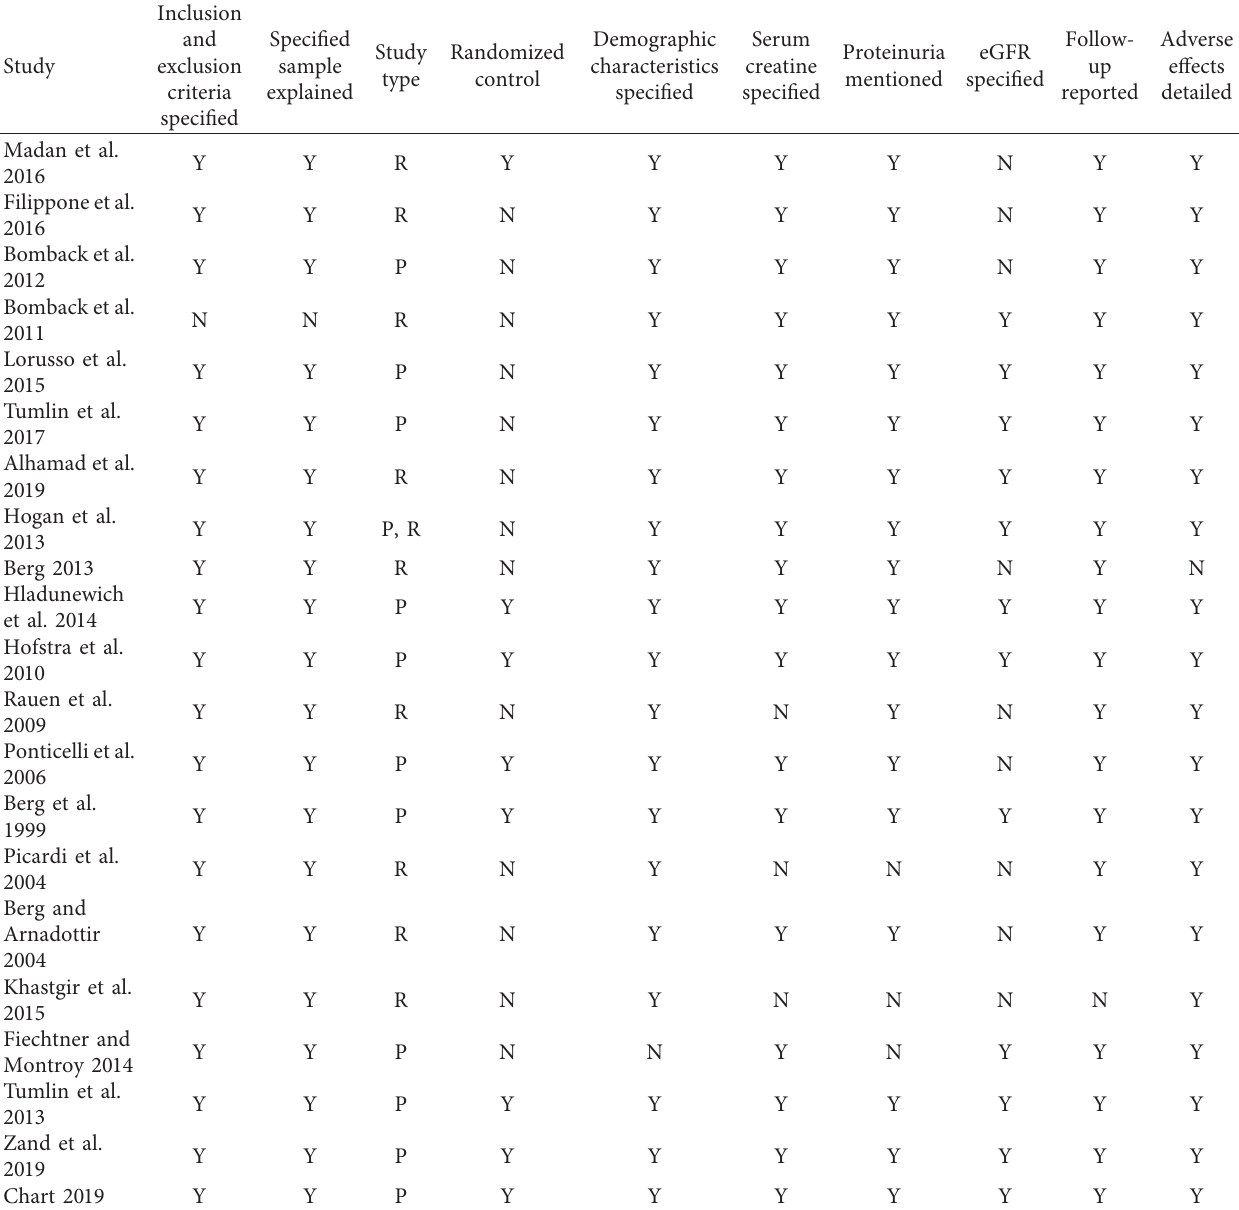
Table 4: Quality criteria checklist for